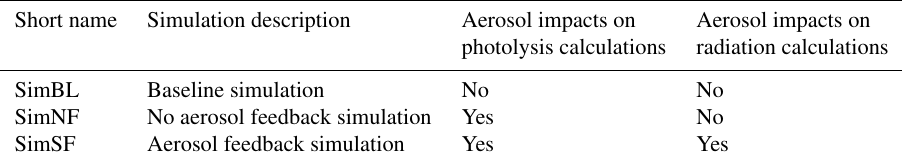
Table 1. Description of sensitivity simulations in this